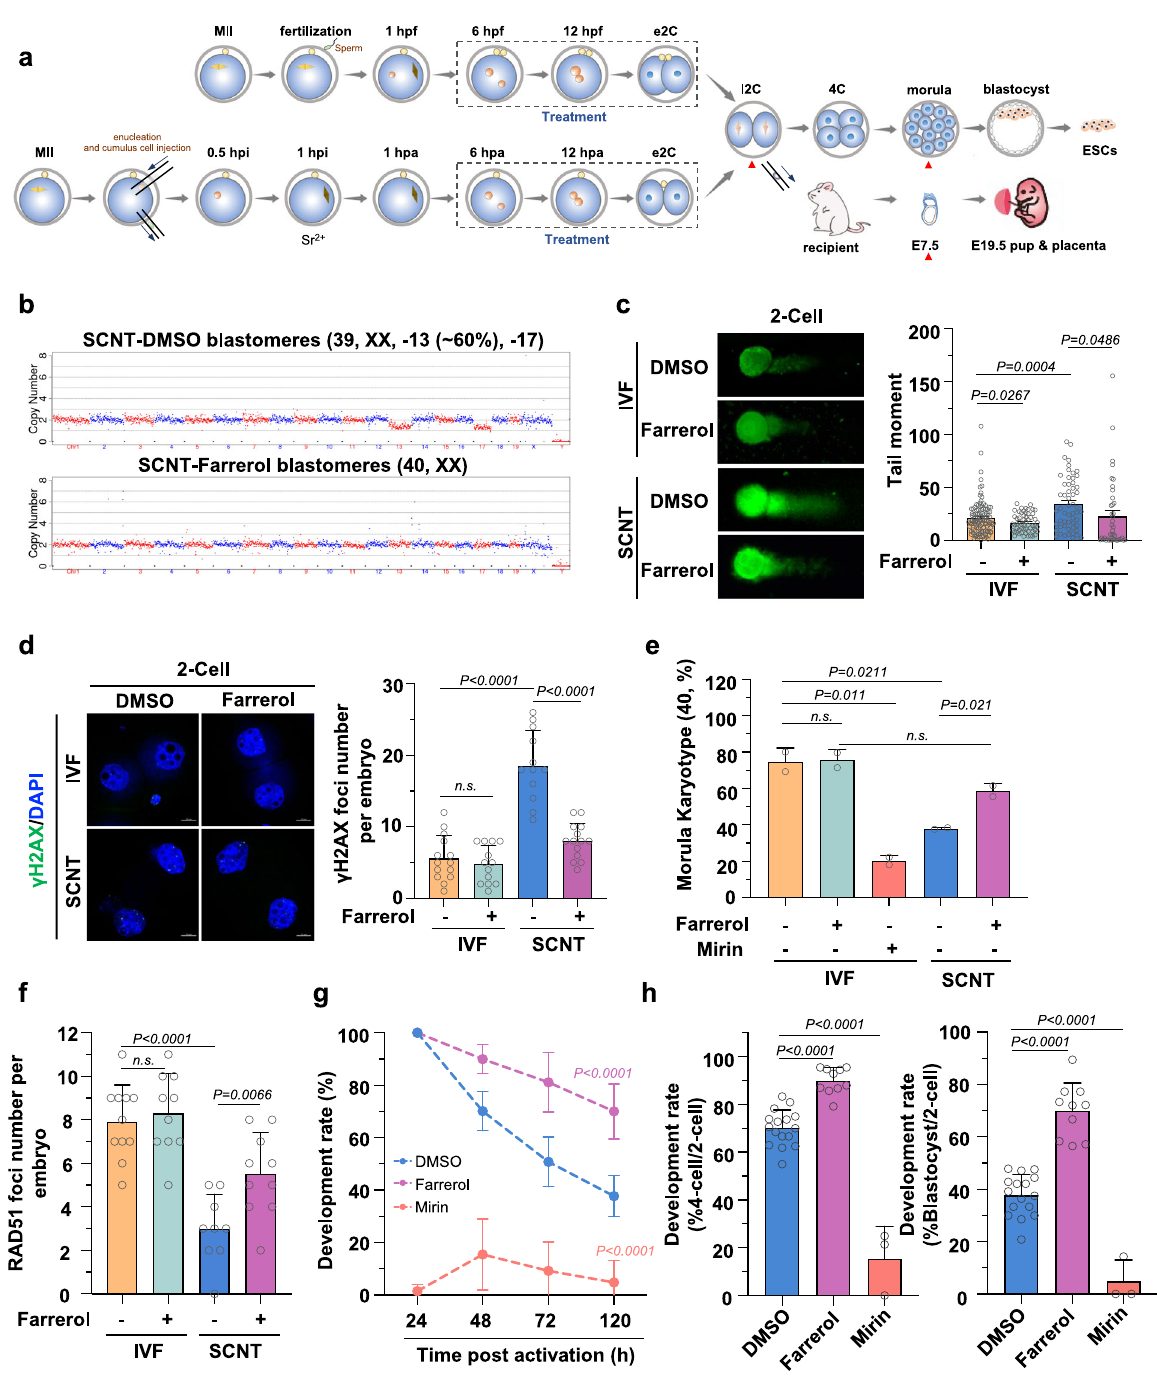
Fig. 4 | Farrerol improved SCNT ef fi ciency. a Schematic diagram showing the preparation of mouse IVF and SCNT embryos treated with DMSO or farrerol for transplantation, in vitro development analysis, RNA-seq (marked by red triangle) and derivation of ESC lines. e2C: early two-cell stage, l2C: late two-cell stage, 4C: four-cell stage, hpf: hours post fertilization, hpi: hours post injection, hpa: hours post activation, E7.5/19.5:embryonicday 7.5/19.5. b Representative images ofcopy number variation (CNV) analysis in SCNT embryos by indicated treatment. SCNT embryos without farrerol showed higher level CNV abnormality. In total, 1 – 2 blas- tomeres from embryos at the four-cell stage were randomly picked for the exam- ination. c Representativephotographs(left)andtheaveragetailmomentbycomet assay (right) detecting two-cell stage embryos in IVF or SCNT group treated with DMSO or 0.05 μ M farrerol. At least 40 cells were counted for each group. d Immuno fl uorescence of two-cell embryos stained with anti- γ H2AX antibodies (green) and DAPI (blue). The average γ H2AX foci number per embryo is shown in